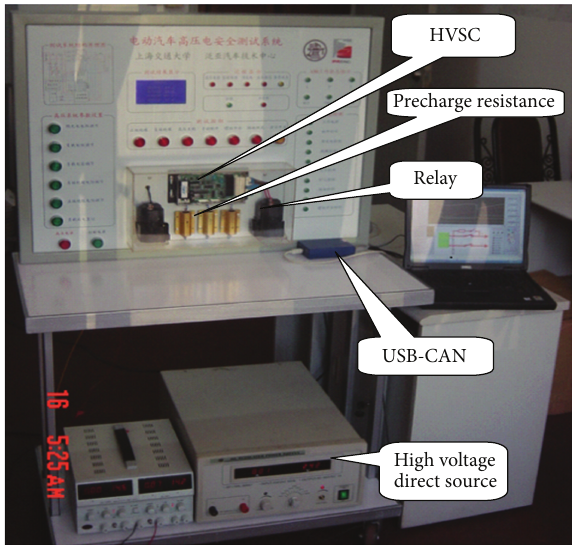
cycle. The safe contact resistance range defined in this work is 0.1 Ω∼ 1 Ω according to the experimental results. The contact resistance computed by formula (7) is based on the cautious Figure 15: The actual experiment table. choice of referenced current ( 𝐼 1 , 𝐼 2 ) and voltage ( 𝑉 11 , 𝑉 22 ). Four different contact resistances (0.1 Ω , 0.2 Ω , 0.3 Ω , and 0.4 Ω ) are connected to the high voltage bus to verify the contact resistance model and calculation strategy discussed above. The test results are shown in Figure 18. The calculation error is between 1% ∼ 6% which indicates that its accuracy is high enough for the EV